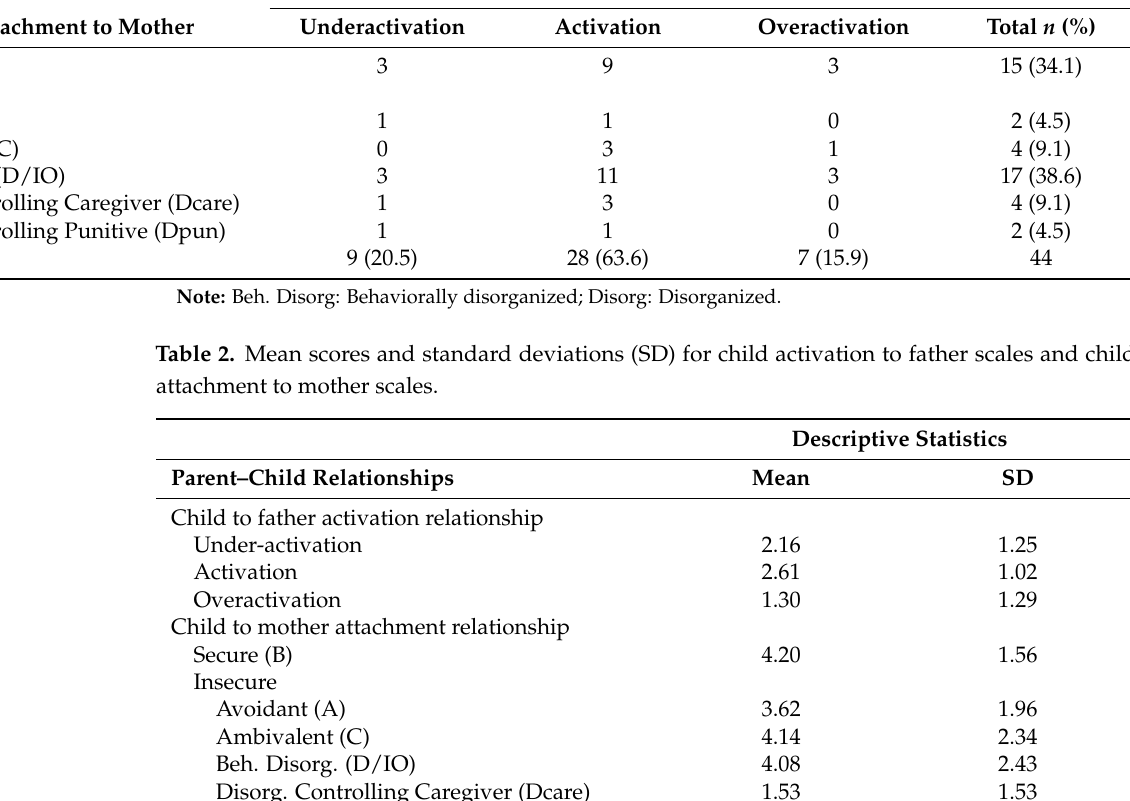
Table 1. Distribution of dyads as a function of the six mother–child attachment and the three father–child activation categories. Child Activation to Father Child Attachment to Mother Underactivation